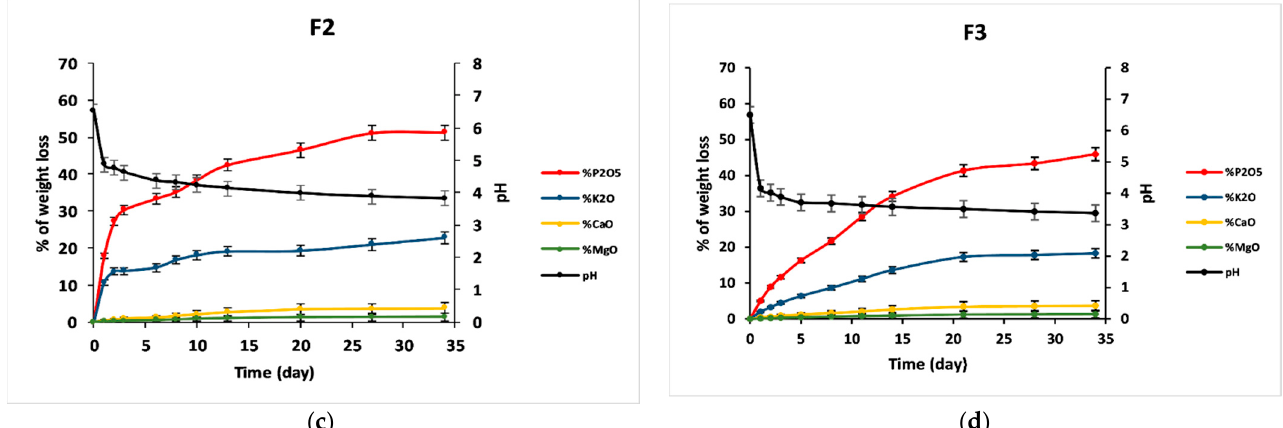
Figure 8. Percentage of glass constituents (macro-elements) analyzed in the leachate solutions (elements in the form of oxides) normalized to the initial glass weight and pH measurements versus time for ( a ) F 0 , ( b ) F 1 , ( c ) F 2, and ( d ) F 3.